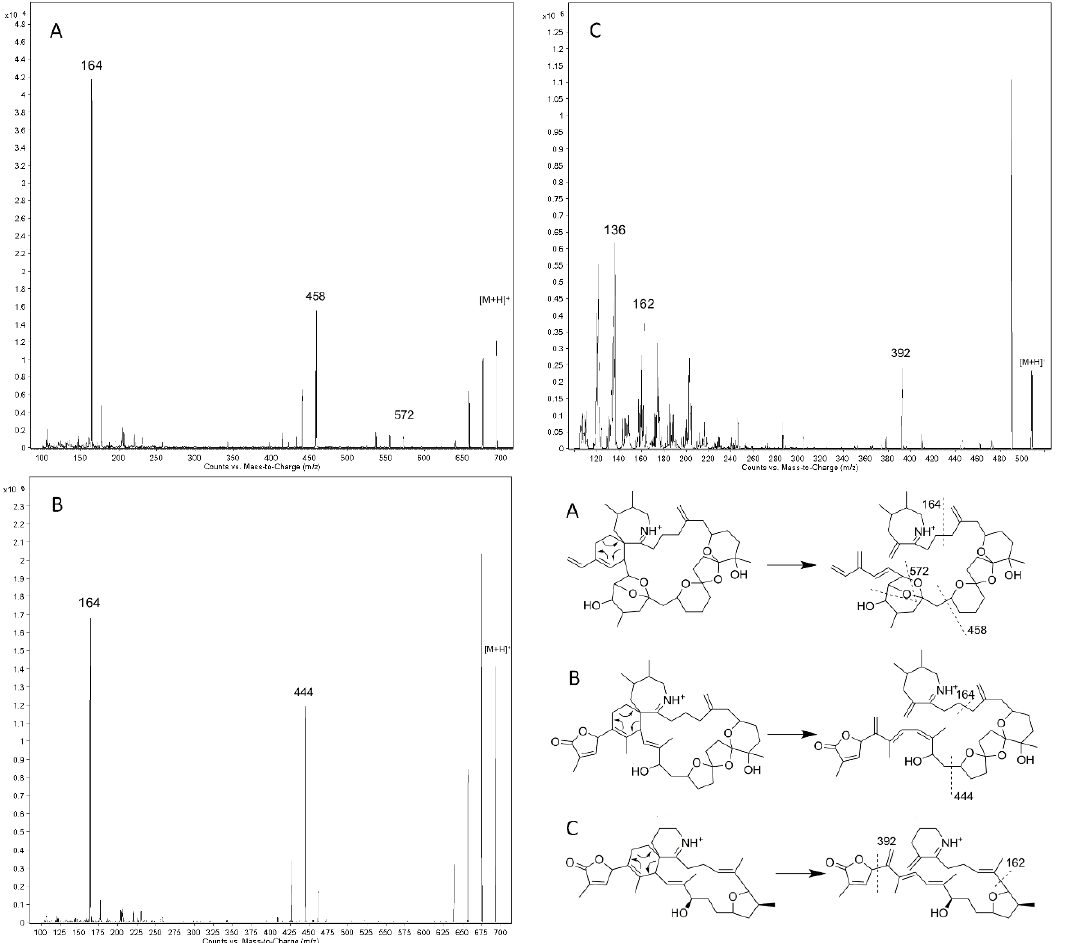
Figure 3. Product ion spectra obtained with a collision energy of 40 eV for PnTX-G ( A ), SPX-1 ( B ), and GYM-A ( C ) and fragmentation pathways.